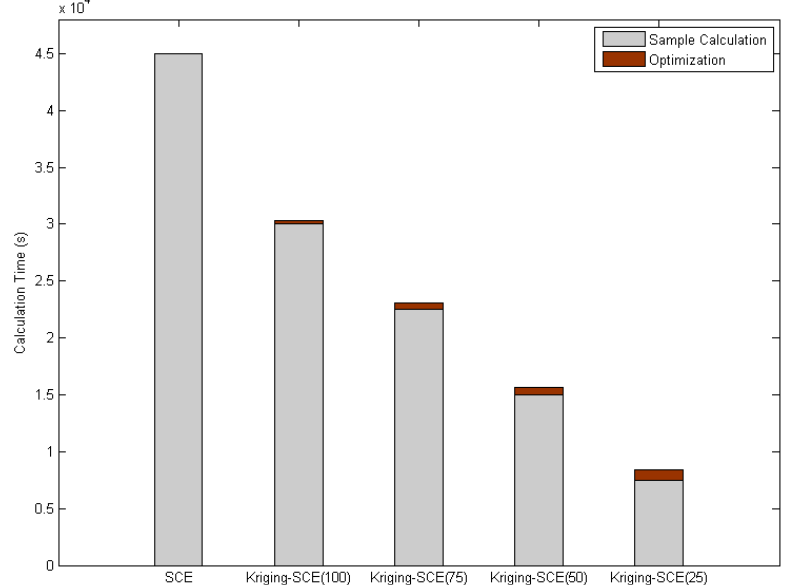
Figure 9. Calculation times.